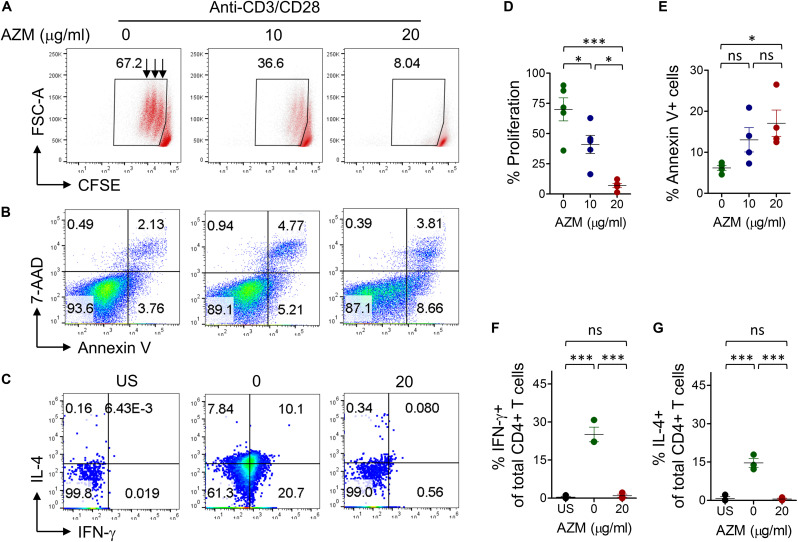
AZM suppresses bulk CD4+ T cells function. (A)
Cell proliferation. CFSE-labeled purified CD4+ T cells were stimulated with anti-CD3 anti-CD28 in presence of indicated concentration of AZM as described in materials and methods. Live cells were gated to detect level of proliferation. Representative FACS plots show the percent CFSE+ cells and each streak in gated population represents a cell division. (D) Aligned dot plots show mean percentage ± SEM cell proliferation. Data shown are from five healthy individuals. (B)
Cell viability. Anti-CD3/CD28 stimulated cells were treated with indicated concentration of AZM. On day 3 cell death assay was performed using Annexin V and 7-AAD labeling. Representative FACS plots show percent apoptosis. (E) Aligned dot plots show mean ± SEM of total Annexin V+ (apoptosis) cells. Data shown are from four healthy individuals. (C)
Cytokine production. Anti-CD3/CD28 stimulated and unstimulated (US) cells were double-stained with anti-IFN-γ and anti-IL-4 mAbs as described in the section “Materials and Methods.” FACS plots show the percent cytokine production by AZM treated and untreated cells. Cells without anti-CD3 and CD28 stimulation were taken as control (US). Aligned dot plots show mean ± SEM of total IFN-γ+ (F) and IL-4+ cells (G). Data shown are from three healthy individuals. *P < 0.05, **P < 0.01, ***P < 0.001, ns stands for non-significant.